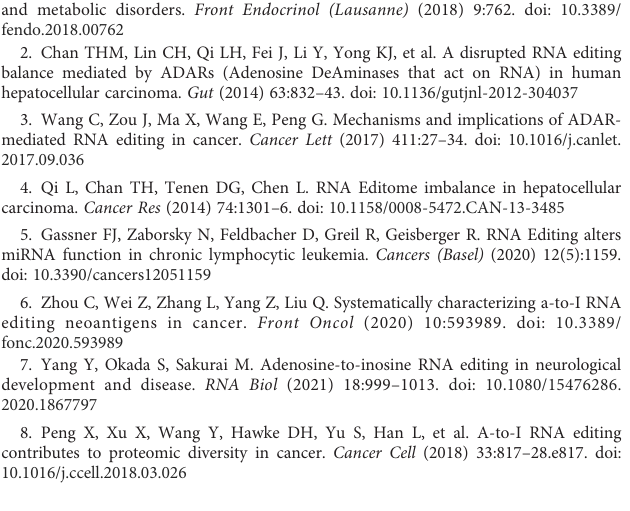
FIGURE S1 Comparison of the Overall A-to-I RNA Editing between Paired Tumor and Normal Samples. (A) The RNA variant distribution in individual sample. (B) The general RNA variant distribution among total samples. (C) The overall distribution of editing sites by chromosomes based on REDItools and SPRINT. (D) The change of editing count between normal and tumor samples based on SPRINT. (E) The change of average editing level between normal and tumor samples based on SPRINT. (F)The distribution of total A-to-I editing sites in repeat region. (G-H) The distribution of A-to-I DREs in different types of RNA regions. (I) The distance to TSS of editing sites between tumor and normal. FIGURE S2 (A) The enriched pathway of the genes with A-to-I DREs. FIGURE S3 Effect of ADARs on pancreatic cancer. (A) The relative expression of ADARs in PDAC based on TCGA and GTEx data. (B) The correlation analysis with overall survivals based on ADARs expression in